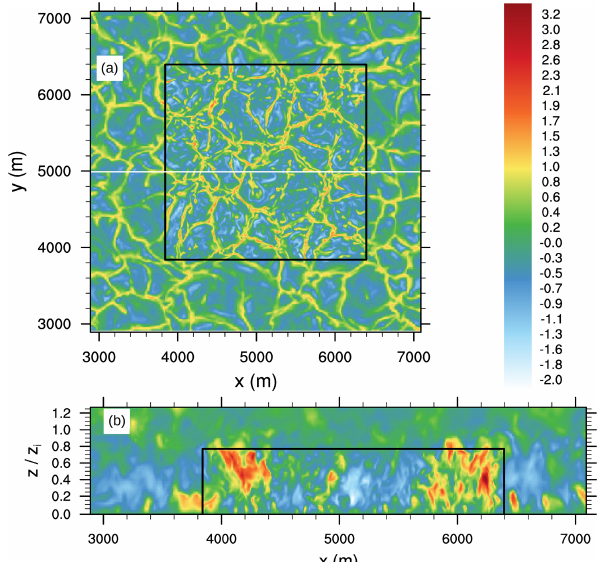
Figure 5. Instantaneous horizontal (a) and vertical (b) cross section of w after 4h of simulated time for the grid-spacing ratio case 2. The horizontal cross section is given at a height of 40m. The black box indicates the lateral and top boundaries of the child domain. The white line indicates the y position of the vertical cross section of w shown in (b) . The vertical axis in (b) is normalized with the horizontal mean boundary layer depth z i . Note that only part of the parent domain is shown for the sake of